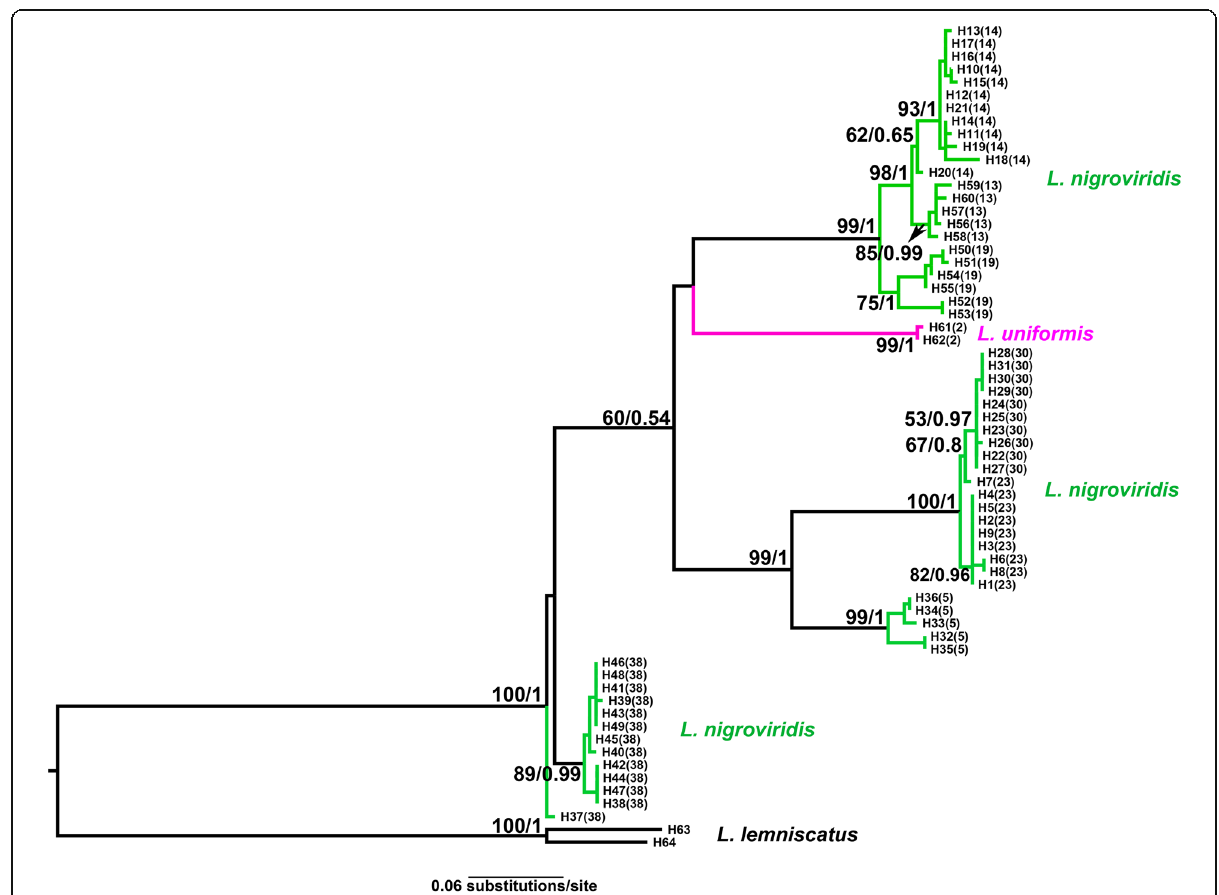
Fig. 3 Maximum likelihood tree for the focal species L. nigroviridis. Maximum likelihood tree based on cytochrome b gene for the focal species L. nigroviridis . Numbers on the branches indicate bootstrap values for maximum likelihood and posterior probabilities for Bayesian inference. Colors of the branches represent L. nigroviridis (in green ) and L. uniformis (in pink )